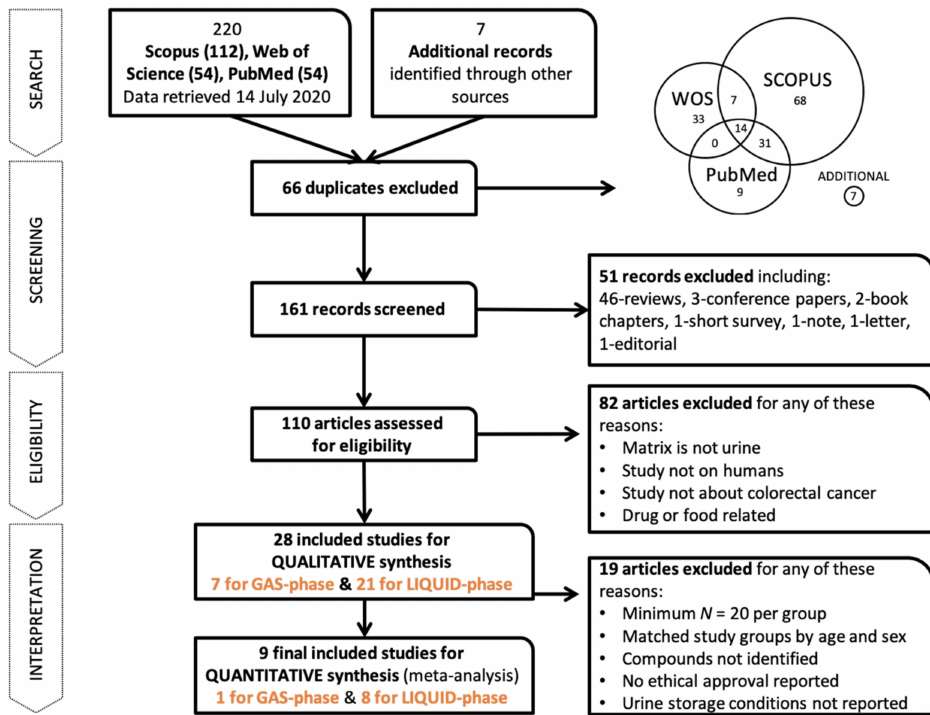
Figure 1. The whole workflow of the systematic